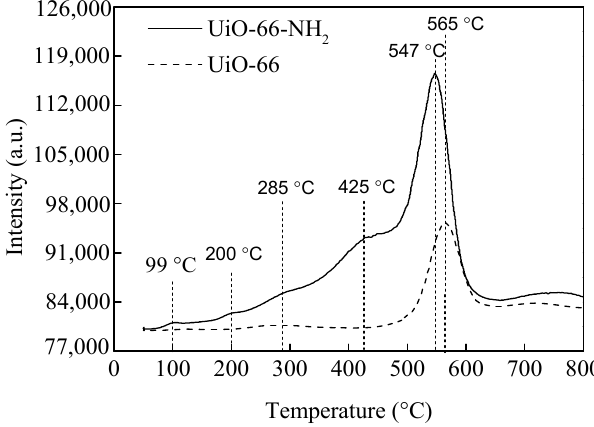
Figure 1. CO 2 -TPD profiles for UiO-66-NH 2 and UiO-66. Table 1. The textural properties of the samples.